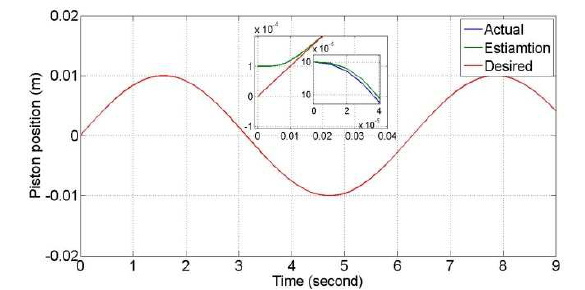
Fig. 16. Closed loop piston position parametric uncertainties tracking desired sinusoidal position. (cid:159) = (cid:160). £